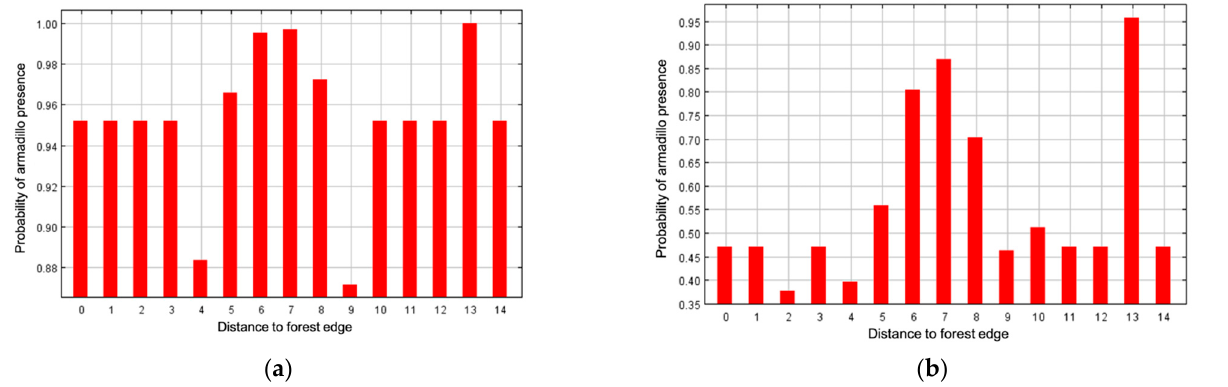
Figure 5. Marginal response curve ( a ) and response curve using only the corresponding variable ( b ) for distance to forest edge as an environmental predictor for presence of nine-banded armadillos in southern Illinois during 2016–2020. Numbers on x axis represent distance from forest edge. Distance from exterior: >4000 m (0), 4000 m (1), 1000 m (3), 500 m (4), 250 m (5), 120 m (6), 60 m (7), 30 m (8). Interior distance from forest edge: 30 m (9), 60 m (10), 120 m (11), 250 m (12), 500 m (13), 1000 m (14). Probability of armadillo presence was higher when closer to forest edge.